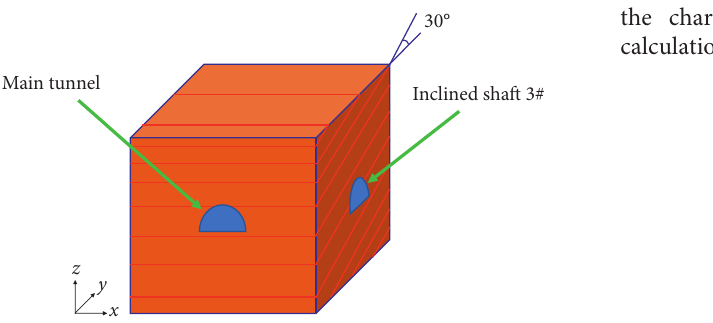
Figure 6: Dip angle of tunnel